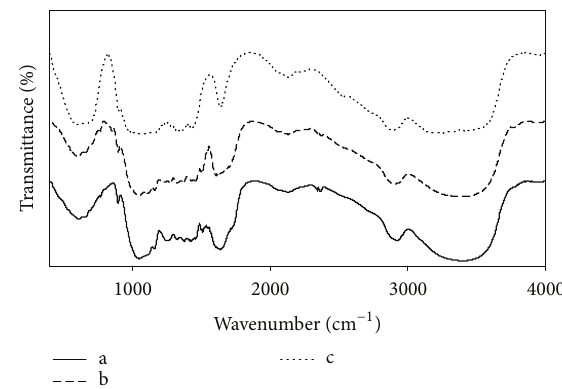
Figure 1: FTIR spectra for (a) raw OPEFB, (b) delignified OPEFB, and (c) OPEFB